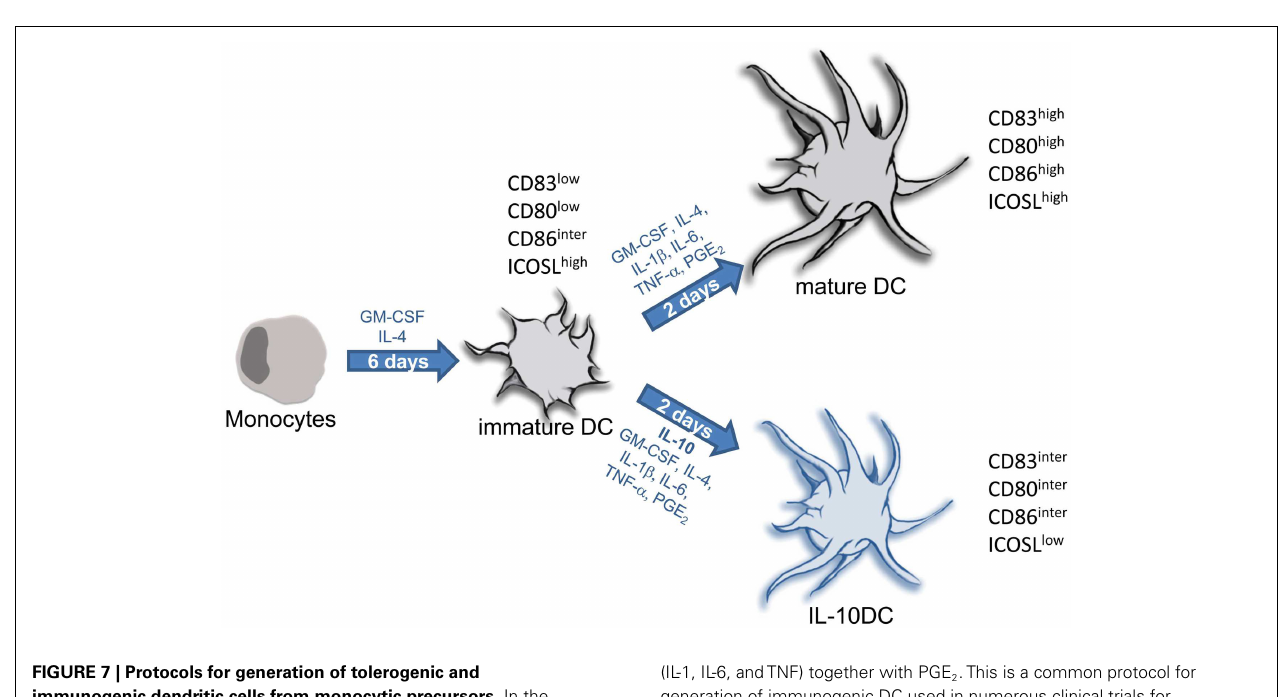
FIGURE 7 | Protocols for generation of tolerogenic and immunogenic dendritic cells from monocytic precursors. In the presence of IL-4 and GM-CSF isolated monocytes differentiate into immature DC within 5–7days.Terminal differentiation into fully mature DC is induced upon stimulation with inflammatory factors